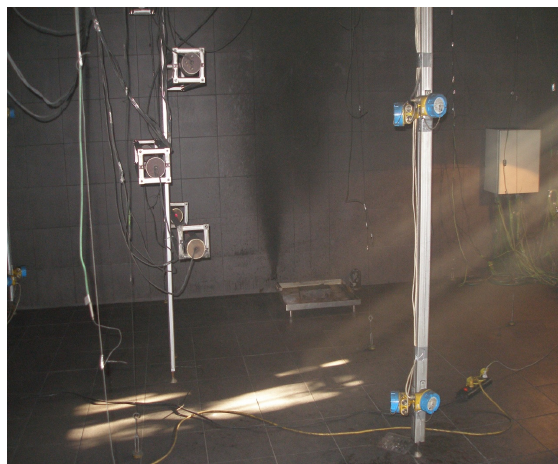
Fig. 3. Interior of the research equipment